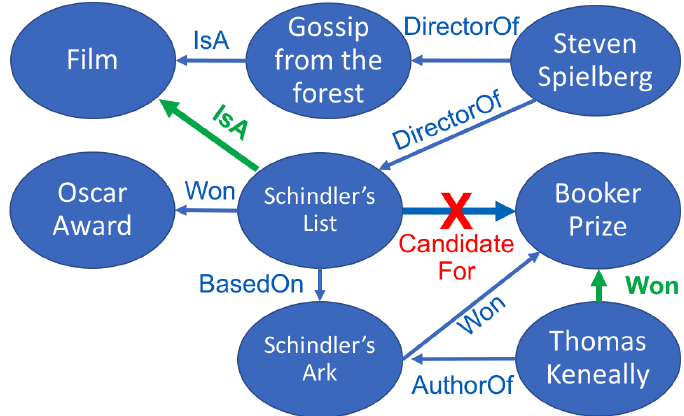
Figure 1. Link prediction and knowledge base validation